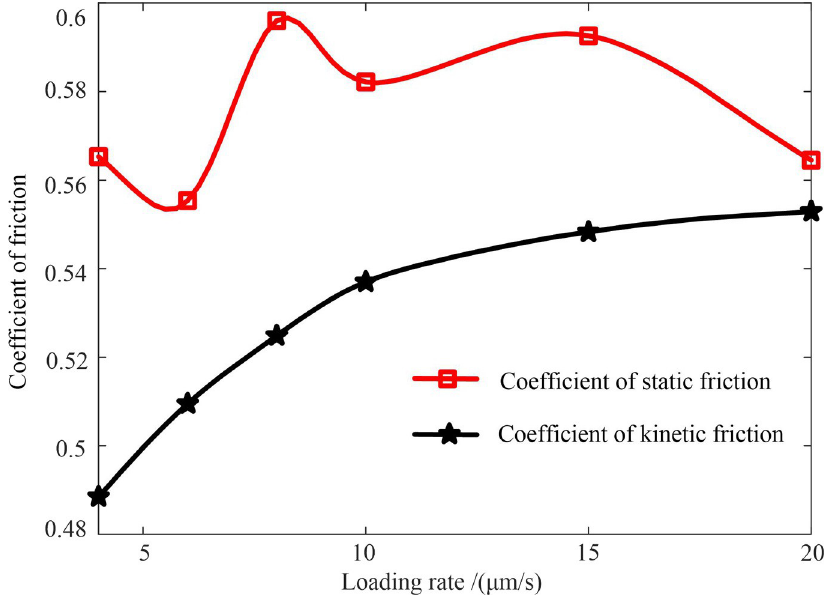
Fig 4. Coefficients of static friction and coefficients of dynamic friction under different loading